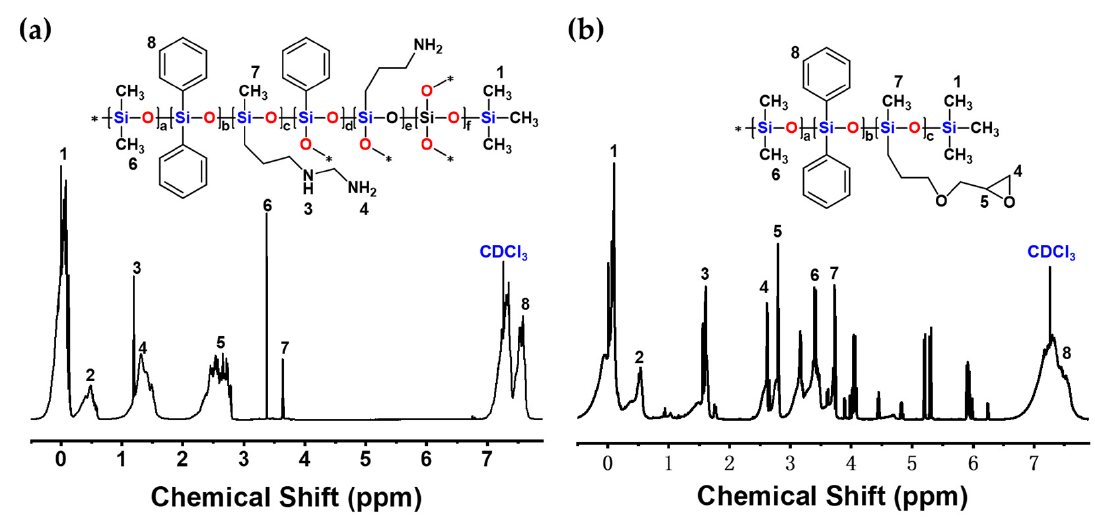
Figure 6. The 1 H-NMR spectra of N75 ( a ) and SE35 ( b